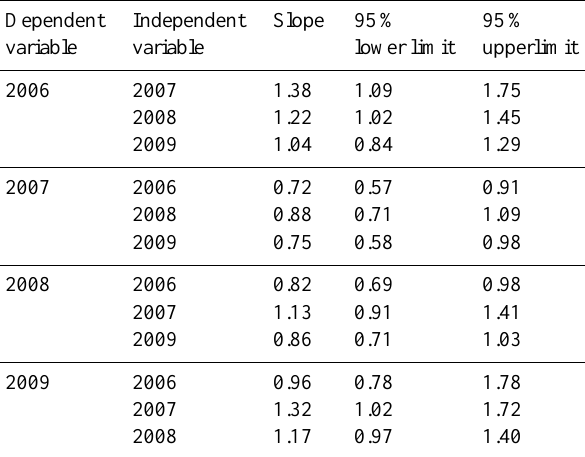
Table 3. Type II regression between ANPP of different years. Slope of regression line, 95% lower limit of slope, and 95% upper limit of slope are shown. All regression lines are highly significant ( P < 0 .